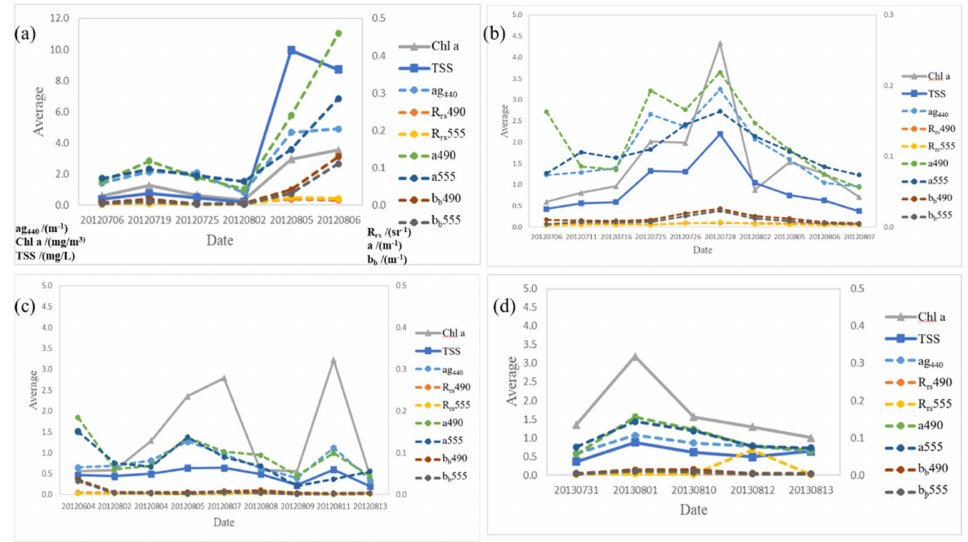
Figure 8. Daily-averaged bio-optical properties evolved in the drifting buoy’s lifetime: Buoy No. 1 ( a ), No. 2 ( b ), No. 3 ( c ), and No. 7 ( d ). The parameter range of the solid line is shown by the left y -axis, while that of the dashed line, by the right y -axis.